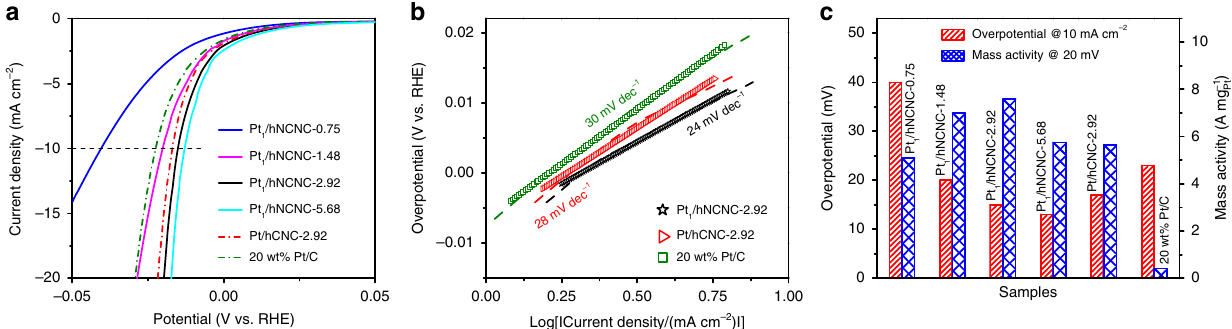
Fig. 3 HER performance of Pt 1 /hNCNC in 0.5 mol L − 1 H 2 SO 4 solution at a scan rate of 5 mV s − 1 after iR -compensation. a Polarization curves. b Tafel plots. c Overpotentials at 10 mA cm − 2 and mass activities at 20 mV (vs. RHE) of the series of catalysts. The data for Pt/hCNC and commercial Pt/C (20 wt% Pt) are presented for